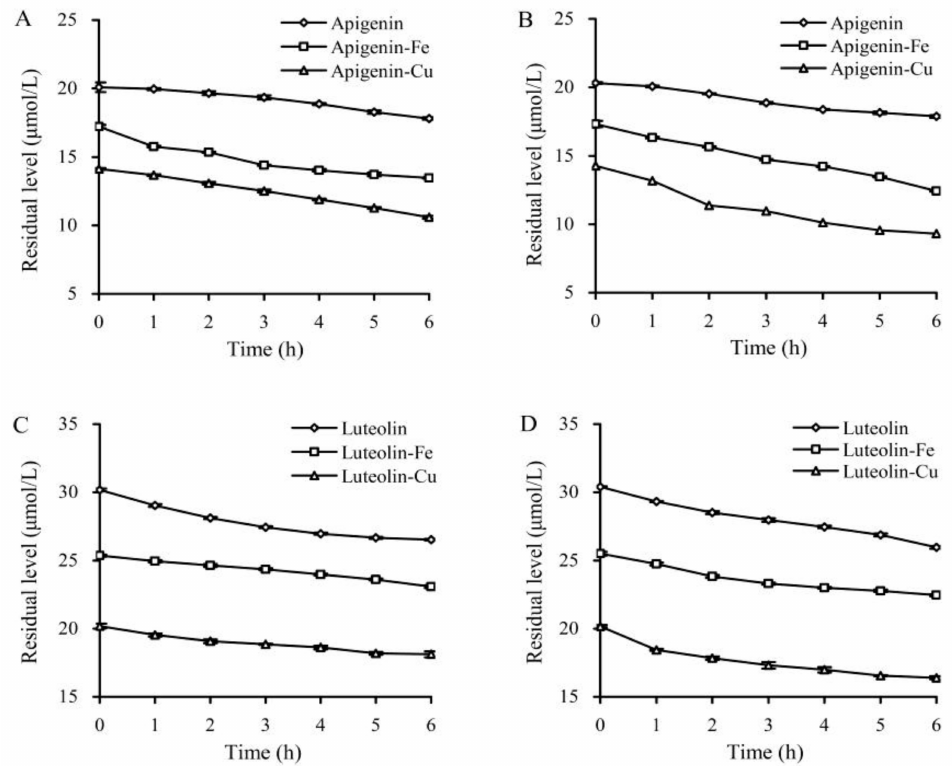
Figure 2. Residual levels of apigenin and luteolin in the solutions incubated at 20 ◦ C ( A , C ) and 37 ◦ C ( B , D ) for di ff erent time